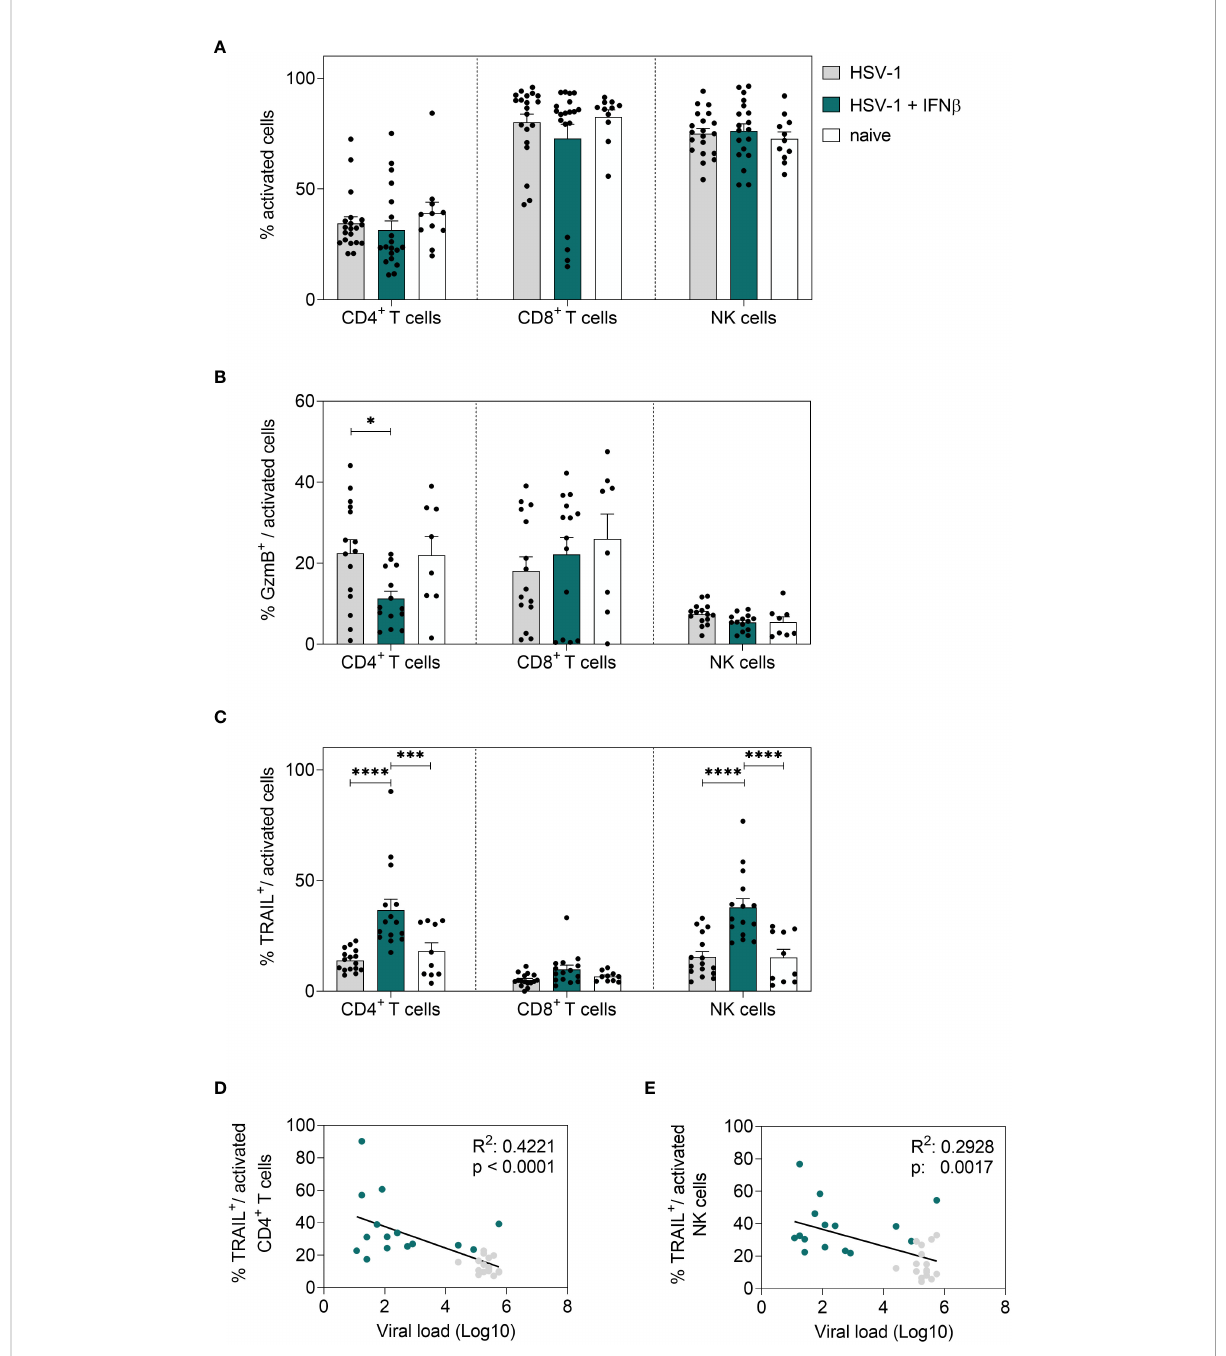
FIGURE 6 Local immune responses in the vaginal tract on day 4 post HSV-1 infection. Female C57BL/6 mice were infected with 1×10 7 TCID 50 of HSV-1 F for four days or left uninfected (naive control). Mice were treated with 8000 U of murine IFN b for two consecutive days starting on day 2 p.i. or left untreated (HSV-1). On day 4 p.i ., vaginal leukocytes were isolated from dissected vaginal tracts. For fl ow cytometric analysis, isolated cells were subsequently stained for respective cell surface and intracellular markers. (A) Frequencies of activated CD4 + T cells, CD8 + T cells and NK cells, frequencies of (B) GzmB + and (C) TRAIL + activated cell subsets are shown. Data points represent individual mice. Bars indicate the mean values ± SEM for each group (HSV-1 n = 15-20 mice, HSV-1 + IFN b n = 14-19 mice, naive n = 8-11 mice). Statistically signi fi cant differences among all study groups were analyzed with the 2way ANOVA and Tukey ’ s multiple comparison test and are depicted by * P < 0.05, *** P < 0.001, **** P < 0.0001. Correlation of frequencies of TRAIL + activated CD4 + T cells (D) or frequencies of TRAIL + activated NK cells (E) and the viral loads (Log10) at 4 dpi of IFN b -treated, HSV-1-infected (teal dots) and untreated, HSV-1-infected (grey dots) mice. Data points represent individual mice. Statistically signi fi cant differences among all study groups were analyzed with simple linear